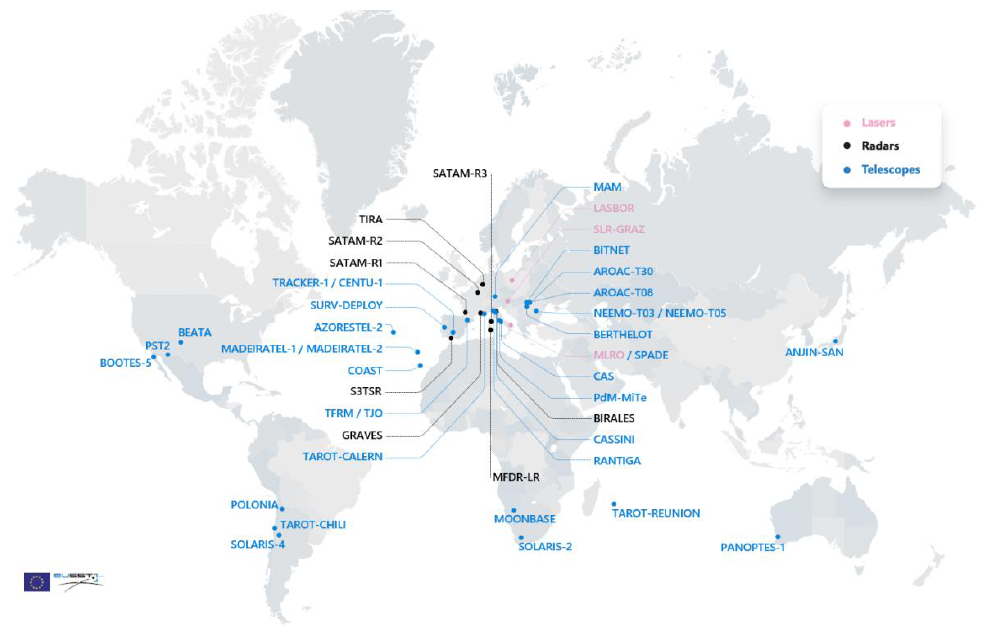
Figure 2. EU SST sensor network status in 2021 Reprinted/adapted with permission from [8] © EU-SST.